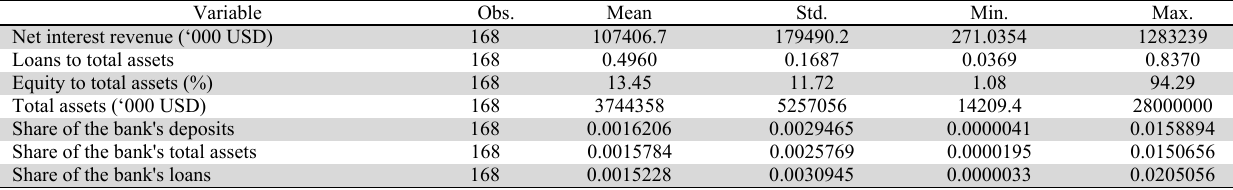
Statistical description in model 3.2, 2005-2012 Variable